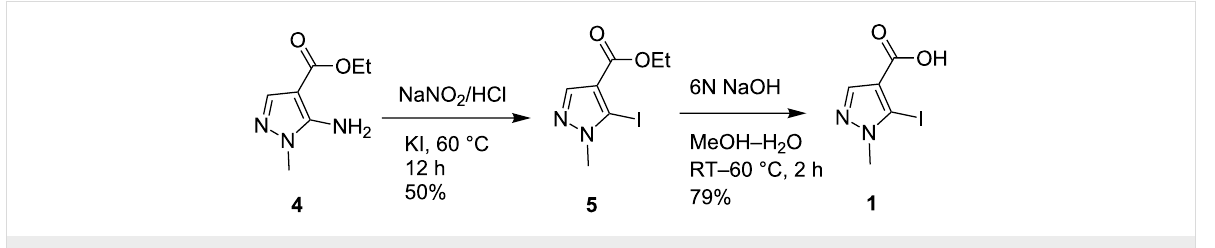
Scheme 2: Preparation of 5-iodo-1-methyl-1 H -pyrazole-4-carboxylic acid ( 1